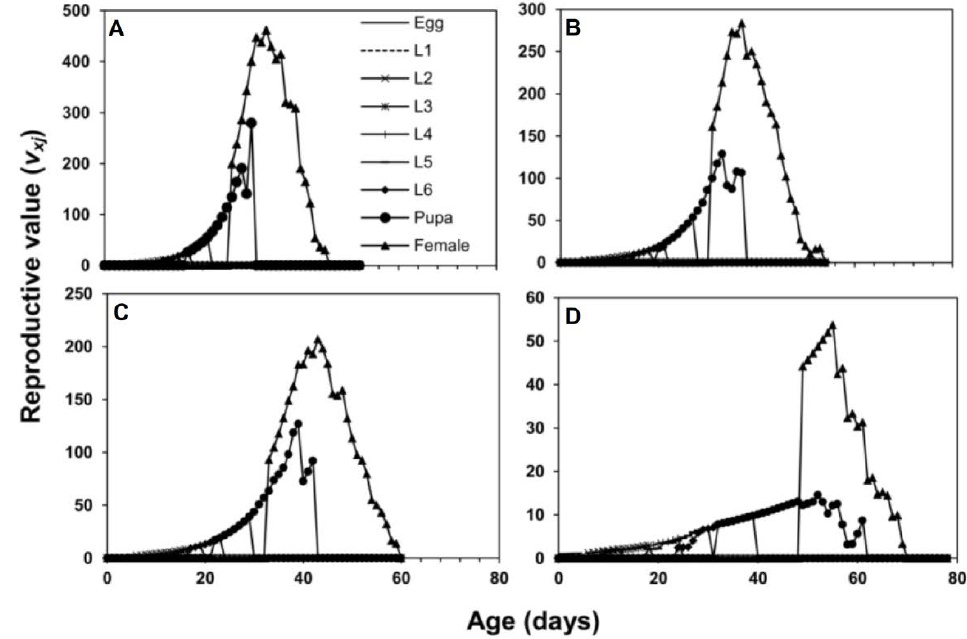
Figure 4. Age stage-specific reproductive rate ( v xj ) of S. frugiperda fed on four host plants, maize ( A ), sorghum ( B ), wheat ( C ) and rice ( D